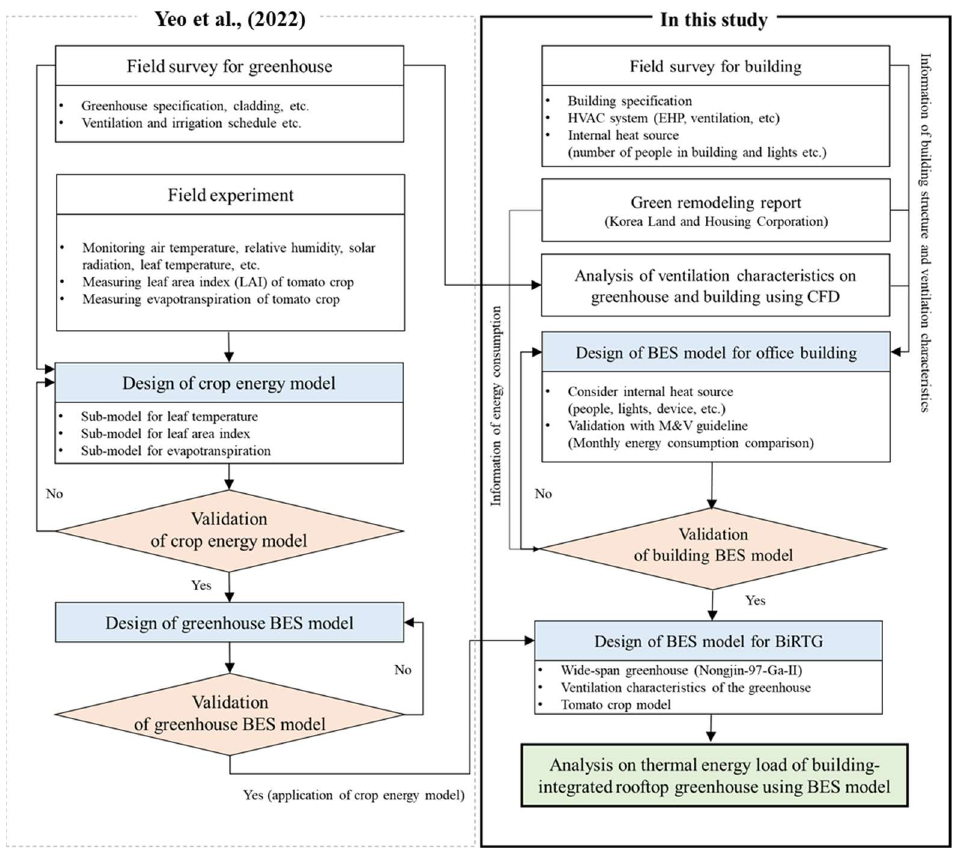
Figure 1. Research flowchart for the design of the BiRTG BES model and thermal energy load anal- ysis.